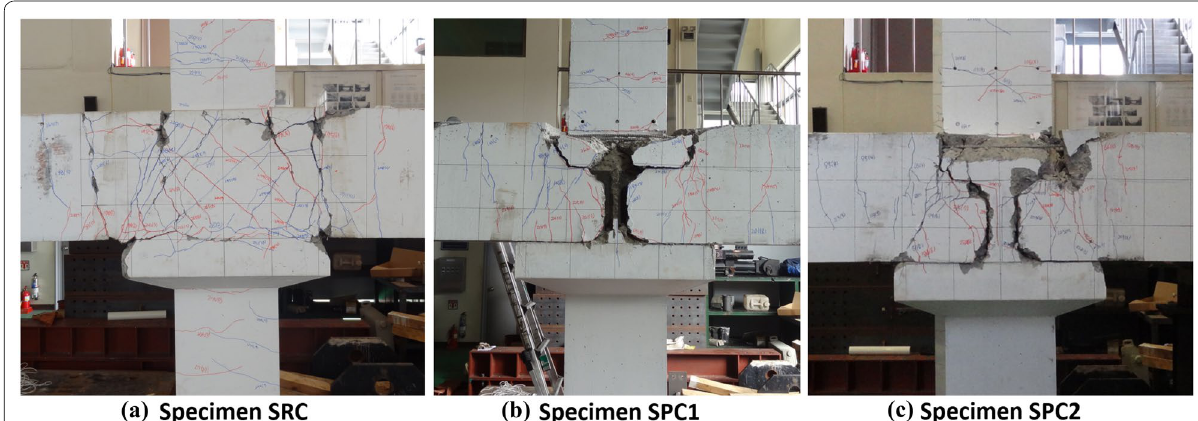
Fig. 14 Damage modes of specimens under gravity loading at the end of the